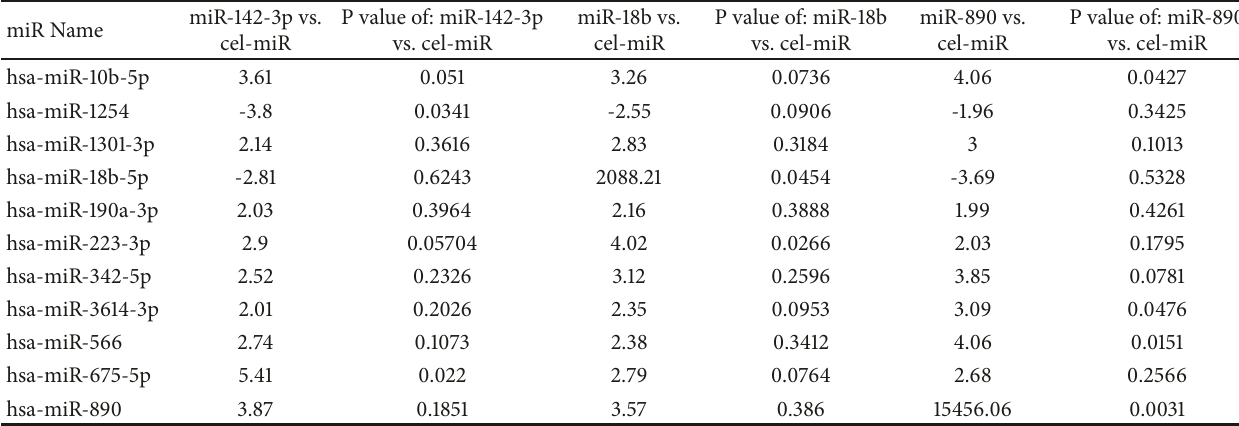
Table 1: Eleven miRs commonly altered in expression levels ( ≥ 2.0-fold) in CRL-1790 cells transfected with MetS-FL miR mimics (miR-142- 3p, miR-18b, and miR-890) compared with cells expressing control cel-miR